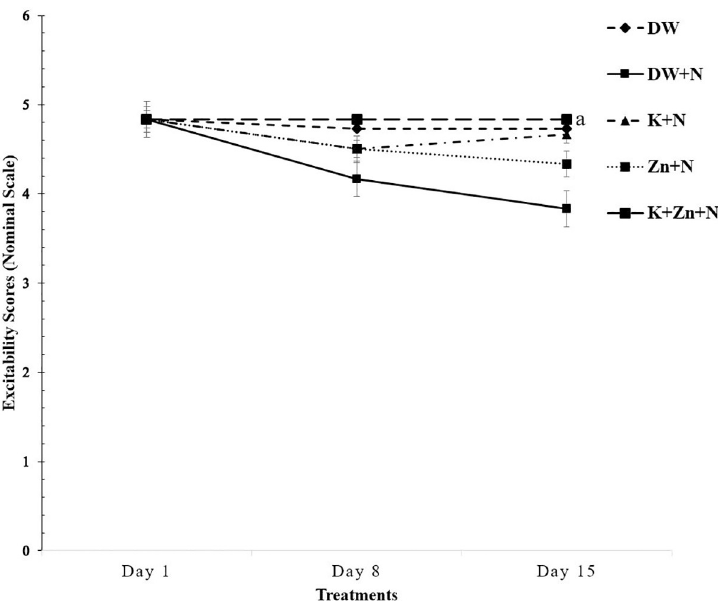
Fig 6. Effect of kaempferol and zinc on sensorimotor reflex in Wistar rats exposed to noise stress (Mean ± SEM, n = 6). a P < 0.05, is significantly different compared to control group (DW+N). DW, Deionized water; K, Kaempferol; Zn, Zinc gluconate; N,